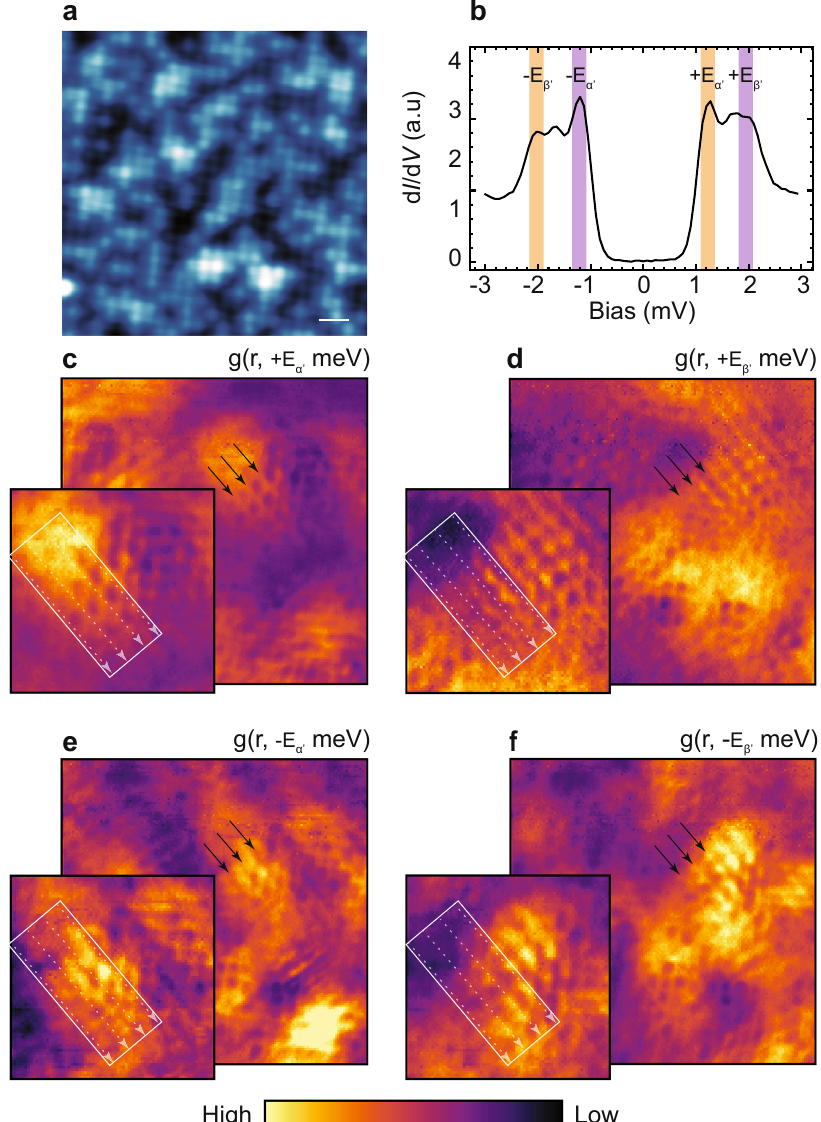
Fig. 3 Multiple contrast reversal in the real space of the Fe sublattice at various energies associated with the peaks of the superconducting gap. a Topography of a 10 nm × 10 nm area obtained on a monolayer of Fe(Se,Te) on Bi 2 Te 3 which shows the Se/Te layer (V Bias = 10 mV, I t = 100 pA, and the scale bar is 1 nm long). b Average dI/dV spectrum obtained at 300 mK in this area showing clear peaks associated with the α 0 and β 0 bands. The peak energies that display modulations of the same phase have been highlighted with the same color. c – f LDOS(r,E) maps (10 nm × 10 nm) obtained on the area shown in a showing the real space modulations different from the Se/Te layer associated with the underlying Fe sublattice. The black arrows in all the DOS maps are aligned with the crests of the modulation in the g(r, þ E α 0 ) slice. They fall on the crests of the modulation in the DOS maps of (cid:3) E β 0 but are off for DOS maps þ E β 0 and (cid:3) E α 0 . Insets show maps at higher spatial resolution of the area around the black arrows. The white square and the translucent arrows are a guide to the eye. The arrows are on the modulations for c and f and off for d and e antiferromagnetic wave vector Q = (0, π ) that mediates the Fermi sampling and all the phases were calculated relative to the phase surface nesting and eventually induces superconductivity. Our of the signal in the dI/dV map at E α 0 i : e :; g q ; þ E α 0 ð Þ : Following data thus shows that the half-embedded layer of Fe (Se,Te) on the PR-QPI protocol described above, we observe that the phase Bi 2 Te 3 is a two-dimensional superconductor with a sign-changing amplitude in the PR-QPI signal for the scattering vector q 2aFe s-wave OP. (averaged over a 4-pixel window) exhibits multiple sign-changes Intriguingly, we also observe an additional relative sign change (Fig. 4b). Our fi rst fi nding is that the PR-QPI signals at opposite between the α ′ and β ′ coherence peaks on the same side of the sides of the Fermi energy are out of phase, i.e., þ E α 0 is out of phase E F . This has not been observed experimentally or studied from the signal at (cid:3) E α 0 , and likewise at þ E β 0 and (cid:3) E β 0 , as shown in Fig. 4b. Sign-changing PR-QPI signals of this nature have been previously. This is seen as a contrast reversal in the pairs of real- previously reported in bulk Fe (Se,Te) and are evidence of a sign space maps on the same side of the Fermi energy i.e., g r ; þ E α 0 ð Þ (cid:1) (cid:3) (cid:1) (cid:3) change of the OP between the hole ( α ′ and β ′ ) and electron ( γ 0 ) (Fig. 3c, d), or g r ; (cid:3) E α 0 ð Þ and g r ; (cid:3) E β 0 (Fig. 3e, f) and g r ; þ E β 0 respectively. The same phase shift can also be clearly detected pockets 16,28 . The origin of the phase shift is believed to be an